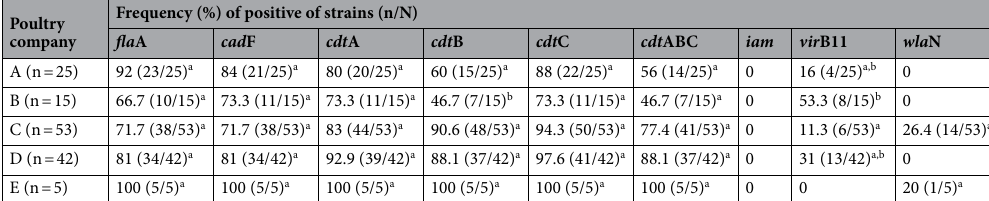
Table 3. Distribution of virulence markers among Campylobacter jejuni strains, according to the poultry company. Different letters in the same column indicate significant differences ( p < 0.010) among poultry companies (Fisher’s exact test; adjusted p